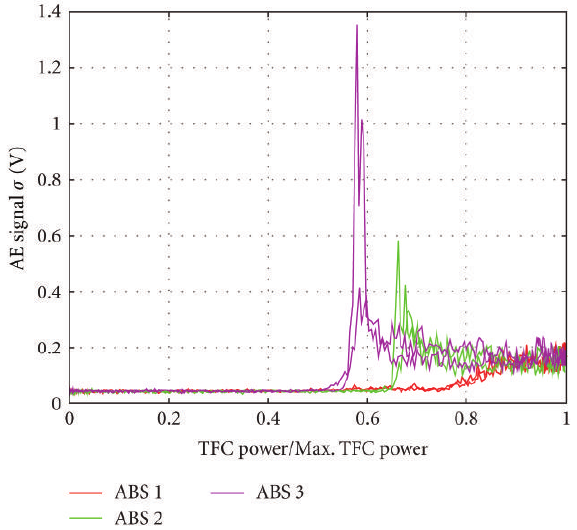
Figure 3: Contact behavior in overpush for the three di ff erent ABS designs.